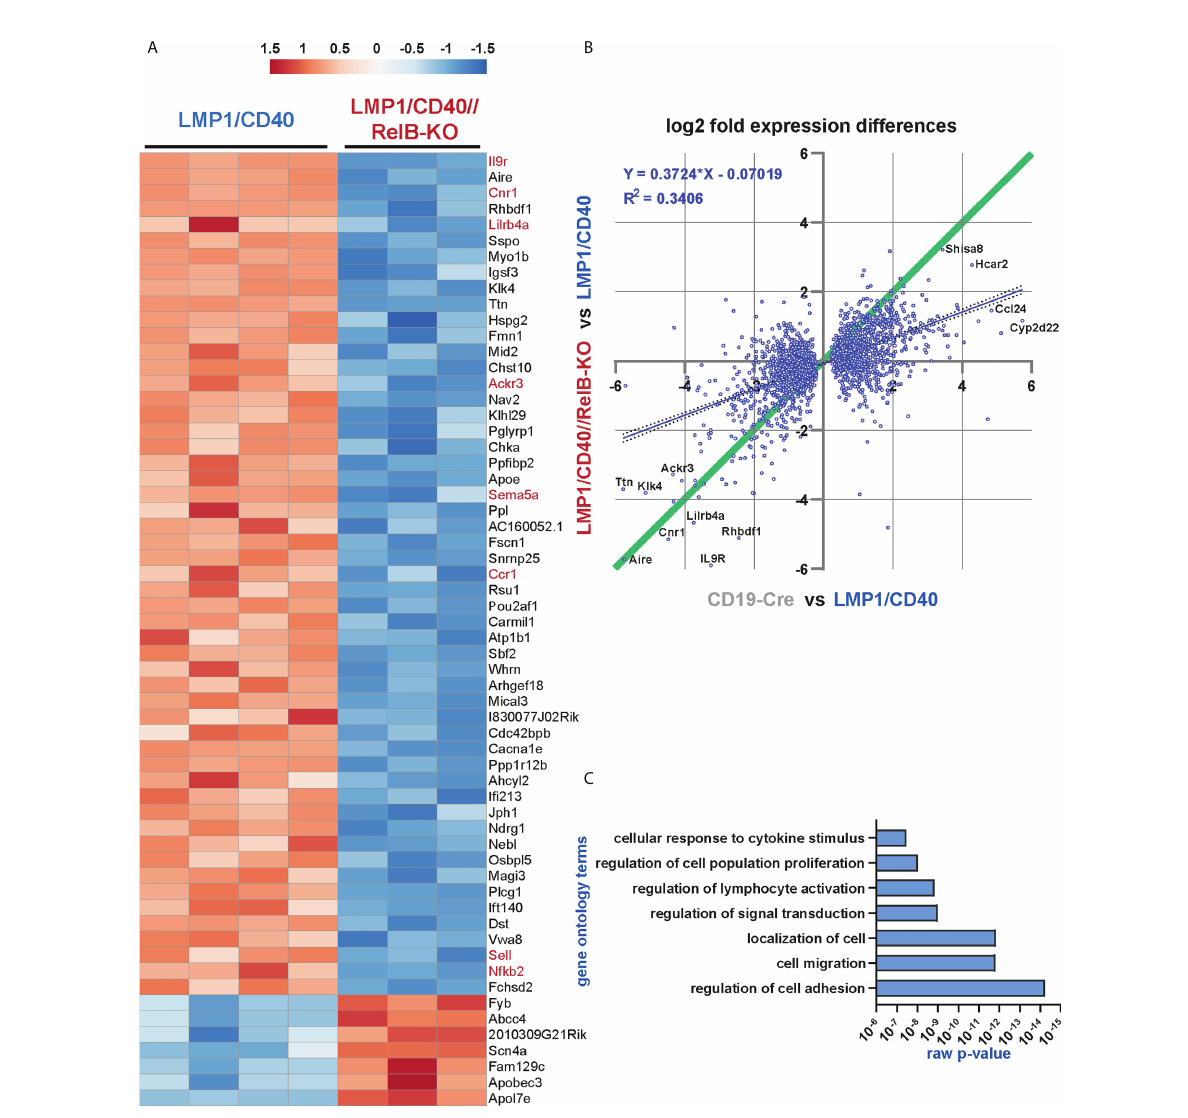
FIGURE 5 The non-canonical NF- ĸ B pathway regulates genes involved in B cell survival, migration and cytokine signaling: RNA-Seq analysis was performed in two rounds. In round 1, the RNA expression pro fi le of splenic B cells from N =4 LMP1/CD40 and N =3 LMP1/CD40//RelB-KO mice was compared, whereas in round 2, the differences in the expression pro fi les of N=4 LMP1/CD40 and N=4 CD19-Cre mice were examined. (A) The heat map shows the most signi fi cant differentially expressed genes between RelB-de fi cient and pro fi cient LMP1/CD40 expressing B cells. The genes indicated in red were further analyzed. (B) Comparison of differentially expressed genes between RelB-pro fi cient vs de fi cient LMP1/CD40 cells and LMP1/CD40 vs CD19-Cre cells. log2-fold differential gene expression values of all commonly expressed genes of both RNAseq analyses are plotted. A cut off at padj < 0.05 for differentially expressed genes was applied to the data from the LMP1/CD40 vs CD19- Cre analysis. Top hits are additionally marked with gene names. The resulting 2670 shared genes strongly correlated (p<0.0001) in differential expression values, the R2 value of the fi tted linear regression trendline (blue, with 95% con fi dence intervals dotted) was added. Genes located along the green line show similar log2-fold expression differences in both RNAseq analyses. Strikingly, RelB-dependent genes with the highest log2-fold changes are located along this diagonal. (C) A gene ontology overrepresentation test was performed with the top 528 differentially regulated genes between LMP1/CD40 and LMP1/CD40//RelB-KO mice (from Suppl. Excel Table 1) using the online tool at [http://pantherdb. org/]. In the graph, a selection of the most signi fi cantly overrepresented GO terms for biological processes is